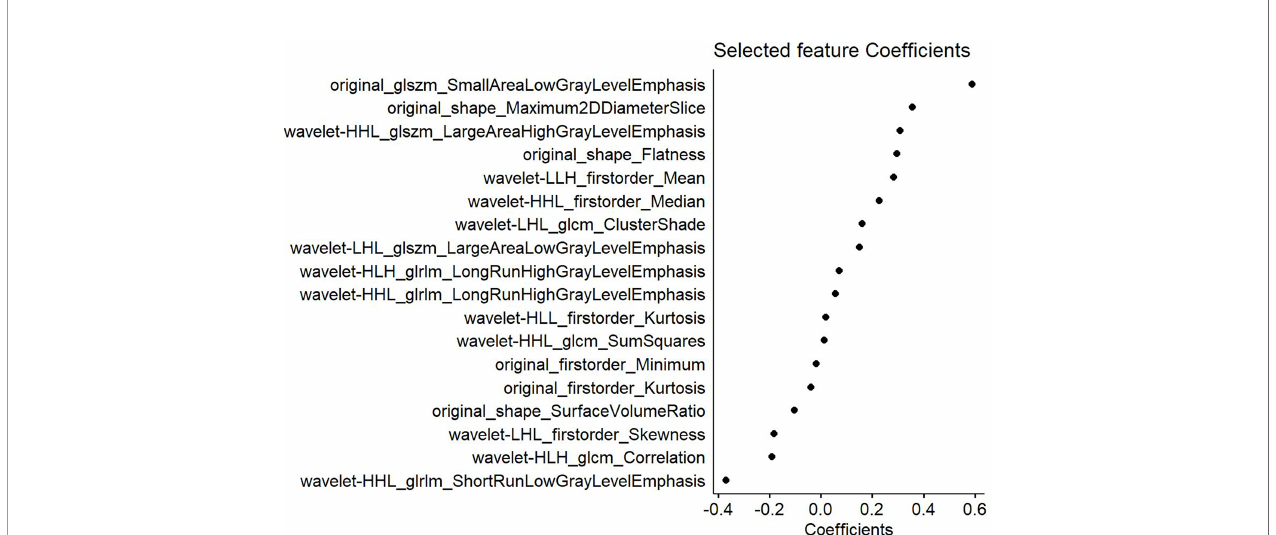
FIGURE 2 | The optimal feature subsets selected by Least Absolute Shrinkage and Selection Operator (LASSO) analysis from the T2-weighted imaging (T2WI) sequence to construct the fi nal model. The upper part shows the optimal l selected at the lowest point of the curve by LASSO analysis. The lower part displays the penalty graph of the variation coef fi cients of the 680 imaging features, with the vertical dotted line indicating that a total of 18 of the most signi fi cant features are obtained at the optimal l value when LogLambda is